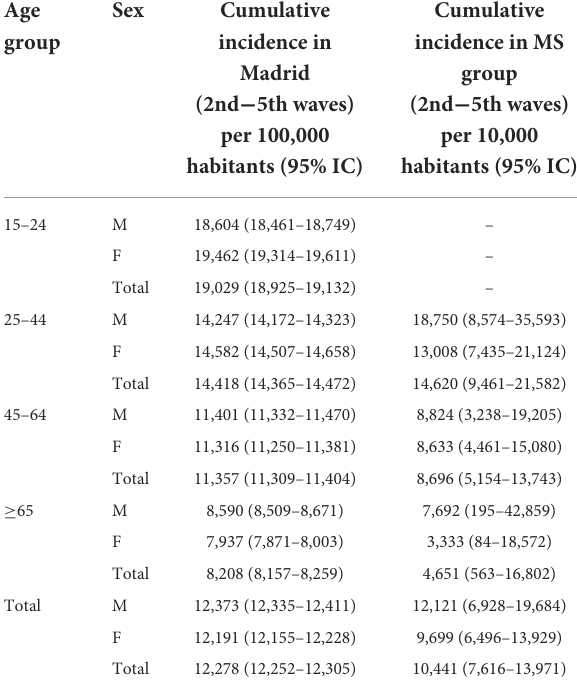
TABLE 2B Age and sex-adjusted cumulative incidences of COVID-19 in our MS cohort and in Madrid population during second to fifth